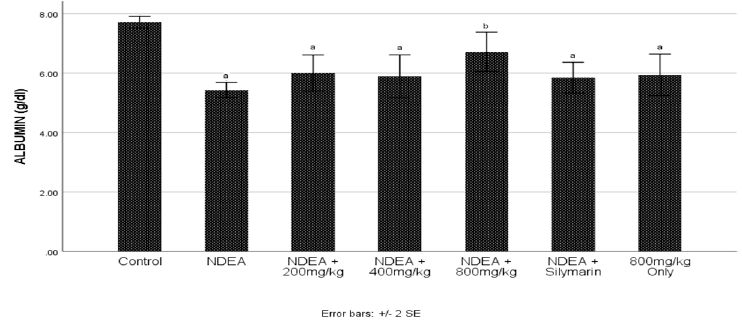
Figure 1. Effect of Cajanus cajan on albumin. Values are expressed as mean ± SEM; a Values differ significantly from control group; b Values differ significantly from the NDEA-treated group.